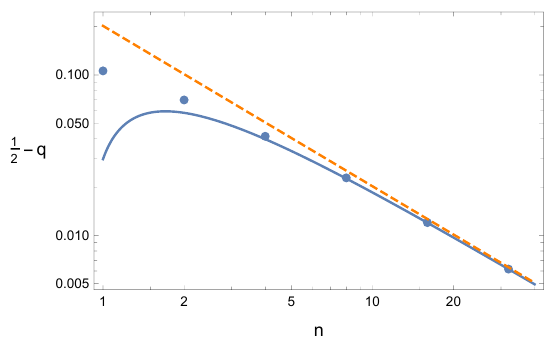
Figure 2 . The points are numerically determined values for q at various values of n for (cid:28) = i. The straight and curved lines are the (cid:12)rst and second order saddle point approximations respectively for 1 (cid:0) q at large n 2